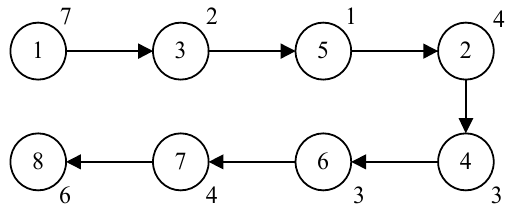
Figure 5. An example result of task sequencing.